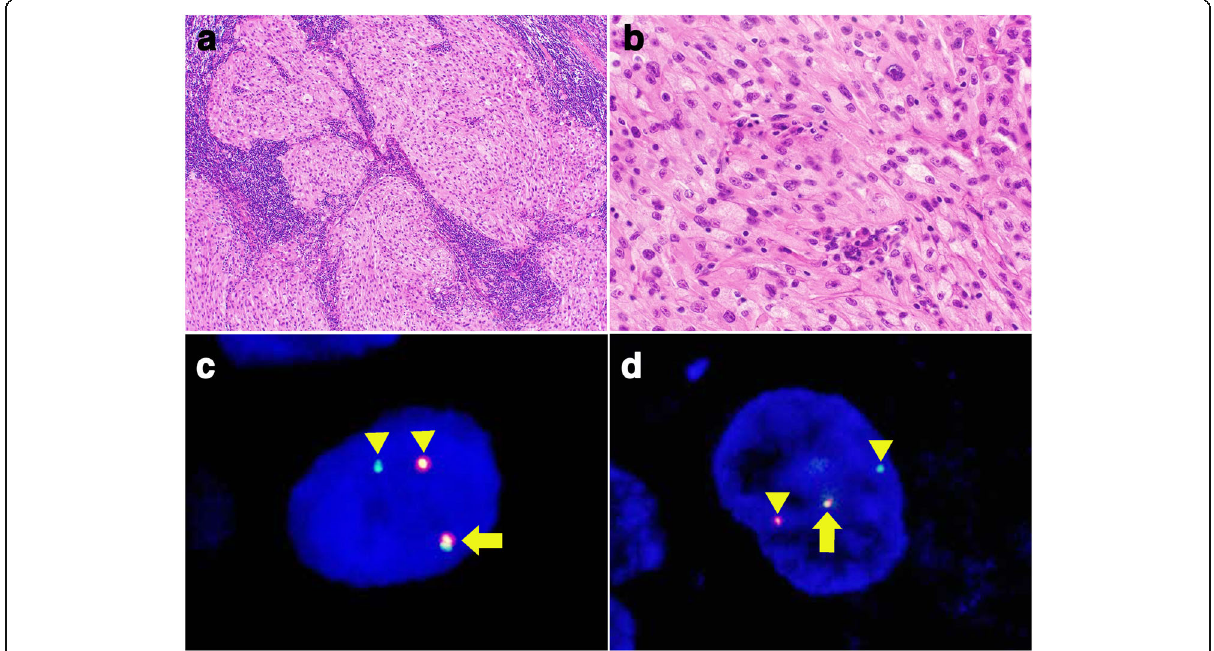
Fig. 2 Pathological findings of CCSST with EWSR1 and CREM rearrangements. a Metastatic CCSST of the lymph nodes (100×). b Tumor cells were polyhedral to spindle-shaped and had oval to round nuclei with pale to clear and eosinophilic cytoplasm (400×). c FISH of EWSR1 split signals. Tumor cells showed EWSR1 split signal with a pair of fused (arrow) and split (arrow head) patterns (1000×). d FISH of CREM split signals. Tumor cells showed CREM split signal with a pair of fused (arrow) and split (arrow head) patterns